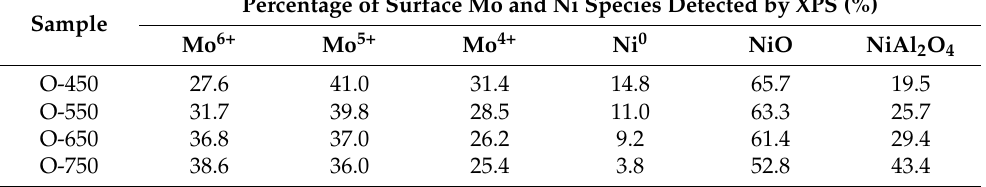
Table 4. Quantitative Ni 2p and Mo 3d XPS analysis for reduced Ni 10 Mo 10 Al catalysts after calcination at 450–750 ◦ C a .